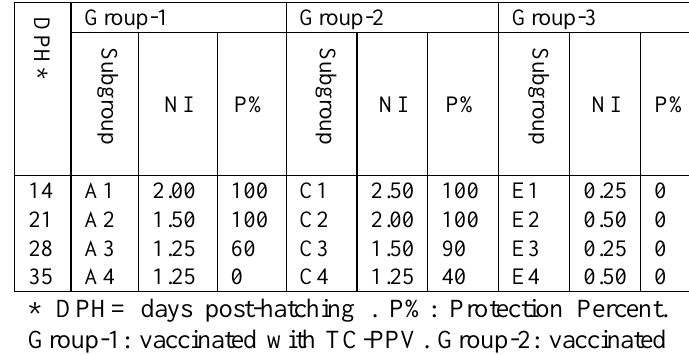
Table 4: Duration of maternal immunity in squab’s offspring of vaccinated pigeons with TC-PPV and EG-PPV using VNT: